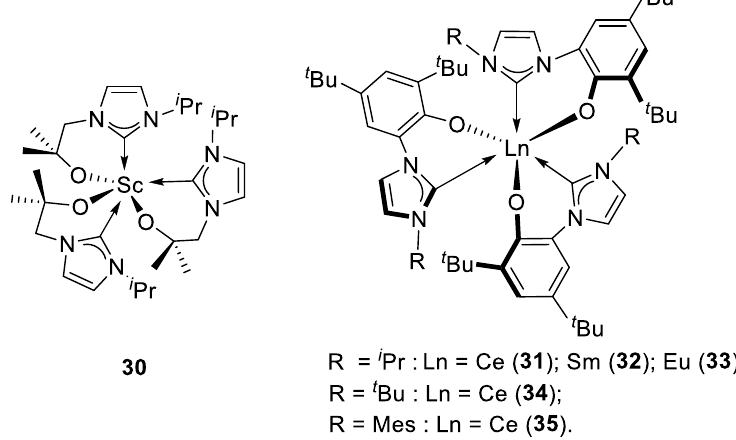
Figure 9. Homoleptic Ln complexes with alkoxo/aryloxo-tethered NHC ligands.